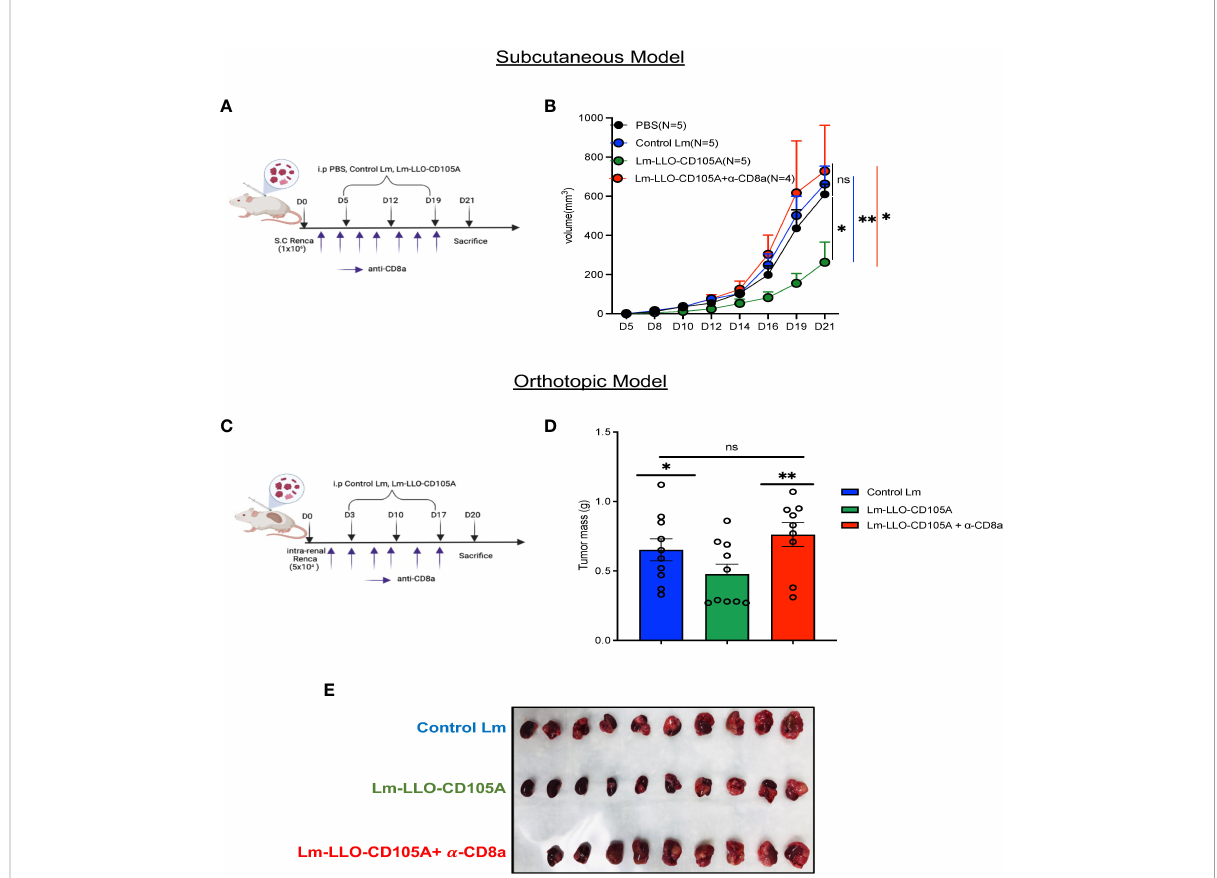
FIGURE 6 CD8 + T cells are responsible for the therapeutic ef fi cacy of Lm-LLO-CD105A. (A) Experimental schedule for subcutaneous CD8 + depletion studies. (B) Longitudinal tumor growth curve. (C) Experimental schedule for orthotopic CD8 + depletion studies. (D) Representative image of diseased kidney. (E) Final kidney mass. n=5-10/group. Data were analyzed using unpaired t-test for subcutaneous model (B) and Mann-Whitney U test for orthotopic model (E) . *P < 0.05, **P < 0.01, ns, not signi fi cant. All error bars are shown as mean ± SEM. Vaccination schedule depiction was made in